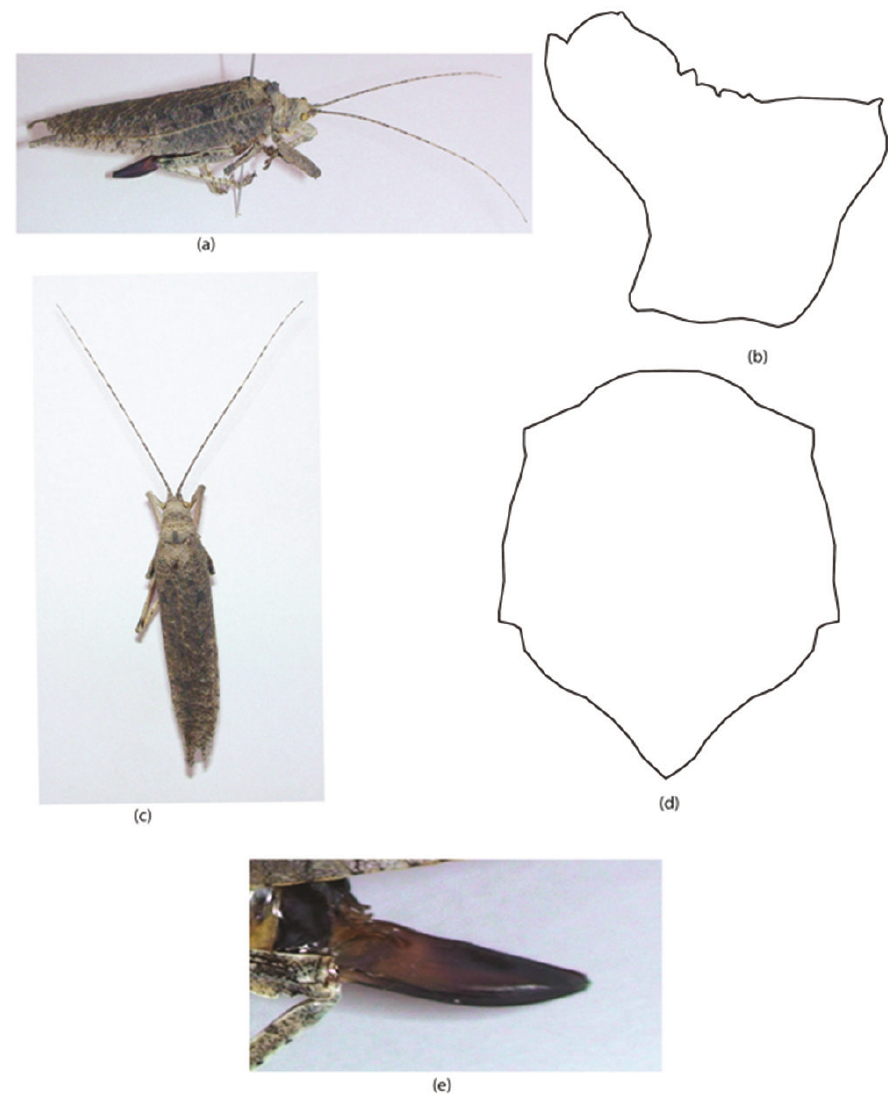
Figure 1. Sathrophyllia nr. rugosa Female; a adult LV b pronotum LV c adult DV d pronotum DV e ovipositor LV. Key: LV = lateral view, DV = dorsal view, VV = ventral view. and hind femur with rounded dots on its lower side. Tegmina slightly shorter than wings. Ovipositor with small teeth on its apex (Fig. 1e). Length measurements. ♀ : pronotum, 6.3 mm; tegmina, 42 mm; femur, 10.3 mm; tibia, 8.7 mm; ovipositor, 10.3 mm; total body length, 25.9 mm. Material examined. Pakistan, Sindh, Tharparkar, Mithi, 1 ♀ , 10.viii.2013, 24.7400°N, 69.8000°E (leg. Riffat S & Waheed